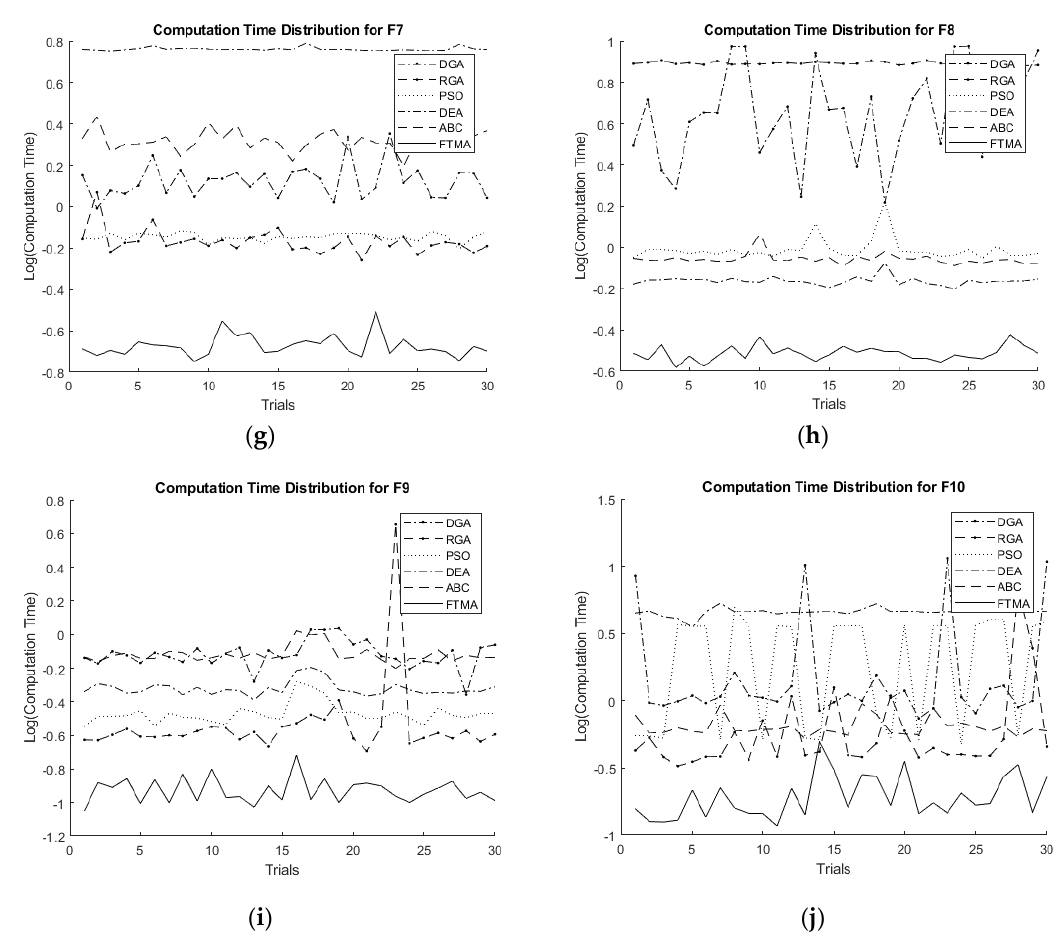
Figure 3. Computation time distribution for the ten benchmark functions. ( a ) F1, ( b ) F2, ( c ) F3, ( d ) F4, ( e ) F5, ( f ) F6, ( g ) F7, ( h ) F8, ( i ) F9, and ( j ) F10.